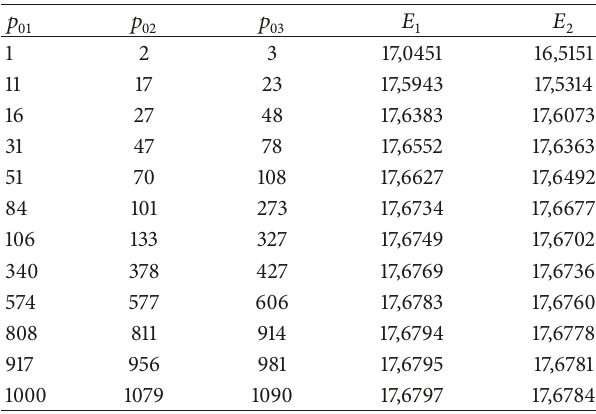
Table 3: The influence of the price on the fishing effort.